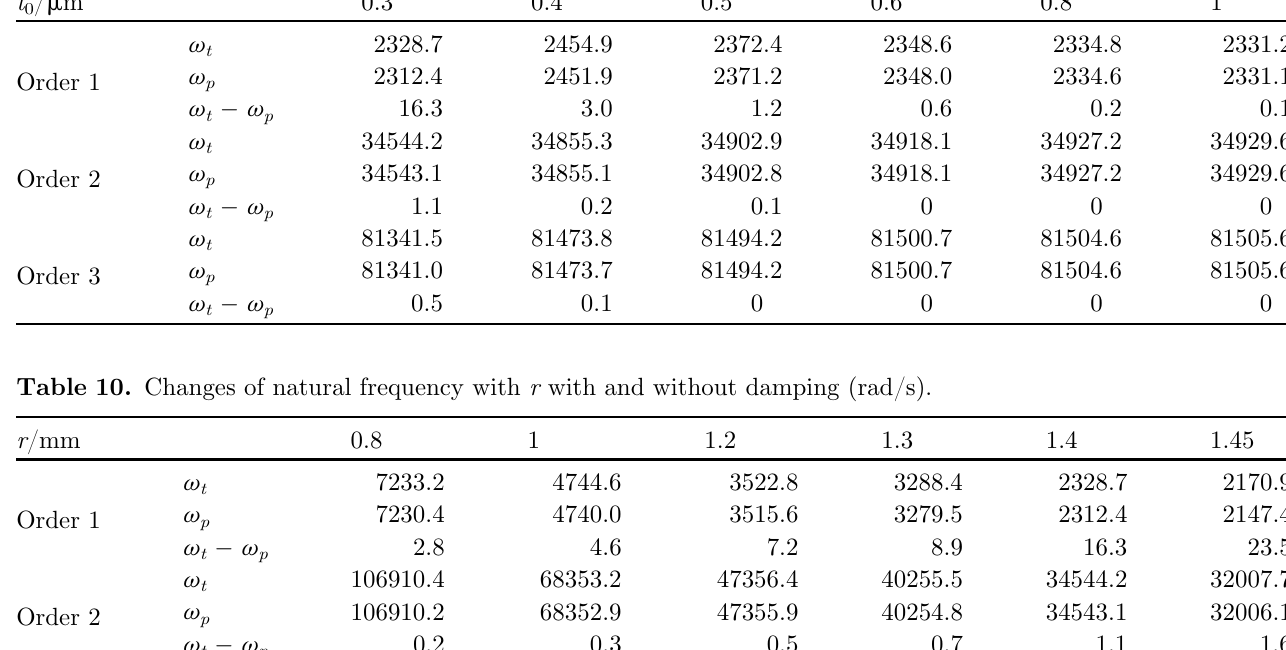
Table 9. Changes of natural frequency with t